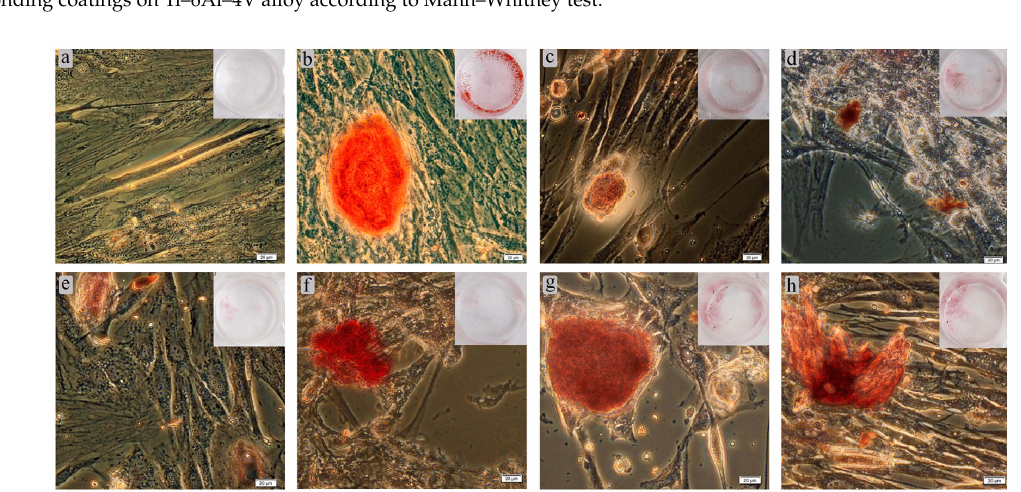
Figure 14. Results of 21-day culture of hAMSCs on plastic surface around Ti–6Al–4V ( c – e ) or Ti–6Al–7Nb ( f – h ) substrates in either standard ( a , c – h ) or StemPro ® ( b ) differentiation media: ( a ) nega- tive staining control; ( b ) positive staining control without test specimens; ( c ) uncoated metal substrate; ( d ) CaP coating; ( e ) Zn–CaP coating; ( f ) uncoated metal substrate; ( g ) CaP coating; ( h ) Zn–CaP coating. Alizarin Red S staining of cell and ECM mineralization. Magnification 200 × ; scale bars = 20 µ